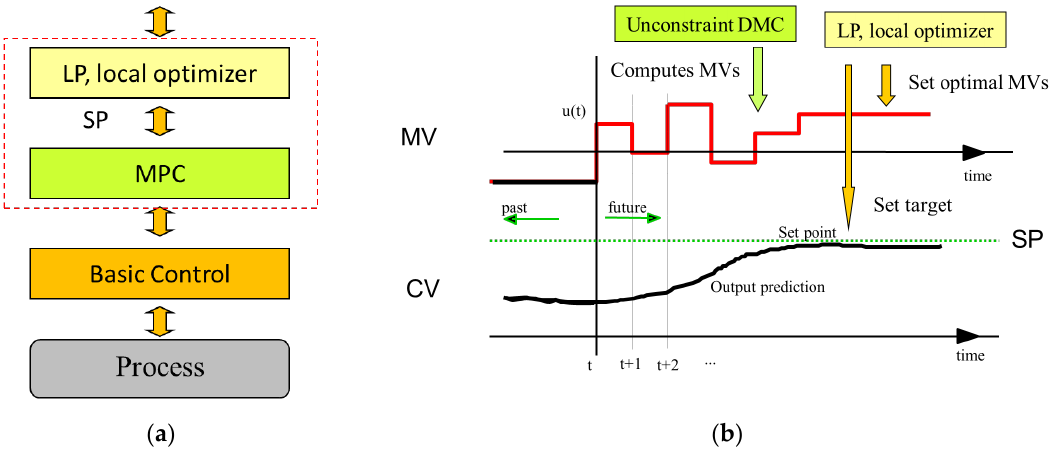
Figure 6. ( a ): Control layers showing the two components of the DMC: Local optimizer and MPC acting on the basic control system; ( b ): Predictions of controlled and manipulated variables with set points and the final targets set by the LP optimizer.